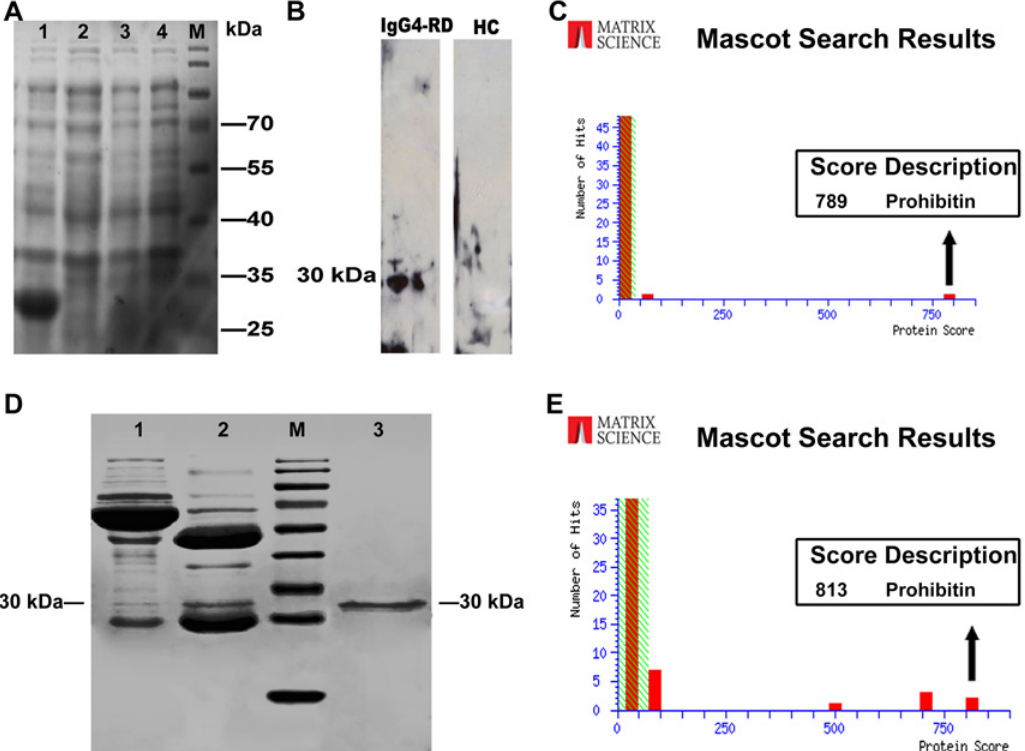
Fig 3. Verification of prohibitin. (A) The cloning, expression and purification of recombinant PHB protein. M, protein markers; lane 1, cell extracts of pET- 28a (+)-PHB/BL21 after IPTG induction for 6 hour at 37°C; lane 2, cell extracts of pET-28a (+)-PHB/BL21 before IPTG induction; lane 3, cell extracts of pET- 28a (+)-BL21 after IPTG induction. lane 4, cell extracts of BL21 after IPTG induction. (B) Western blot using purified PHB protein showed that only the sera from patients with IgG4-RD (lane 1) rather than HC (lane 2) contain antibodies against a 30 kDa cellular protein. (C) The expressed protein was purified and further identified by MS, which revealed its identity as PHB. (D) PHB protein was also identified in immunoprecipitates; lane 1, supernatant of immunoprecipitation; lane 2, immunoprecipitates; lane 3, control sample (the purified rhPHB). (E) The protein band on lane 2 was excised and identified by MALDI-TOF/TOF MS, which again revealed its identity as